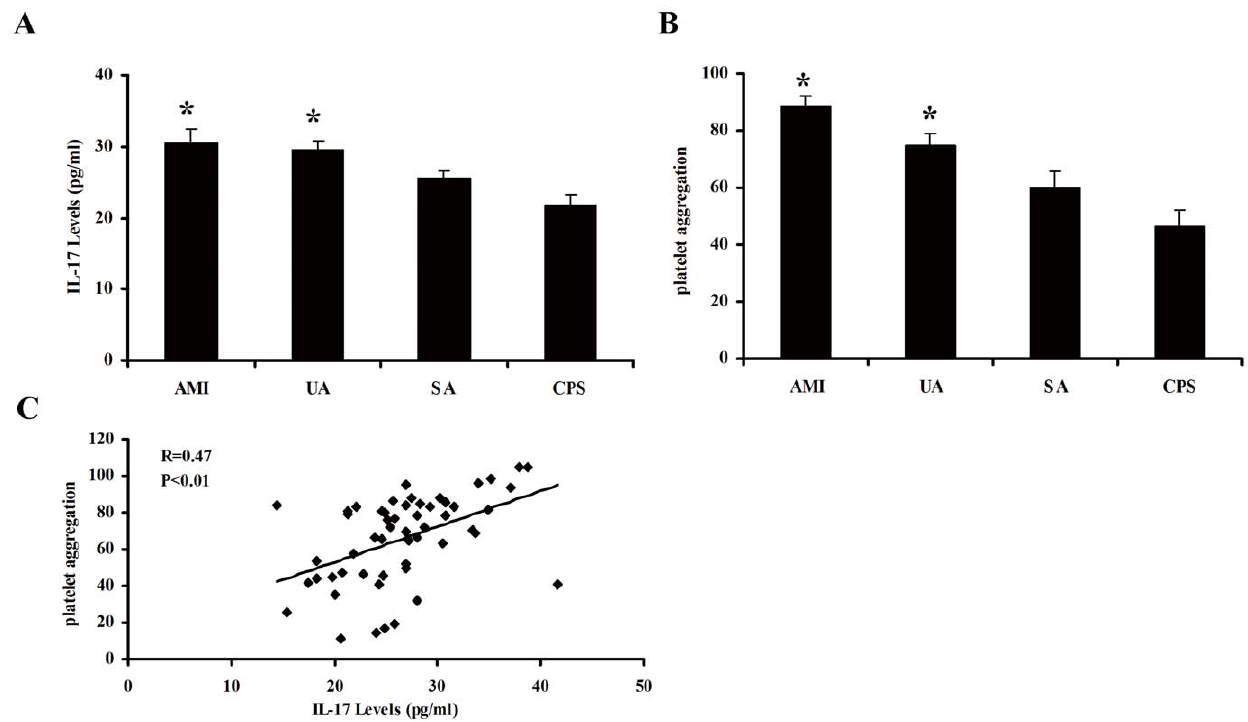
Figure 1. The levels of plasma IL-17A and platelet aggregation in patients with CHD. (A) The levels of plasma IL-17A were detected in different groups, including AMI (10), UA (15), SA (15) and CPS (14). (B) The levels of platelet aggregation were measured in different groups, including AMI (10), UA (15), SA (15) and CPS (14). (C) The correlation analysis of plasma IL-17A and platelet aggregation levels. Each point represents an individual patient, the correlation index (R) is 0.47, p , 0.01. *, p , 0.05 vs SA and CPS group. Values are means 6